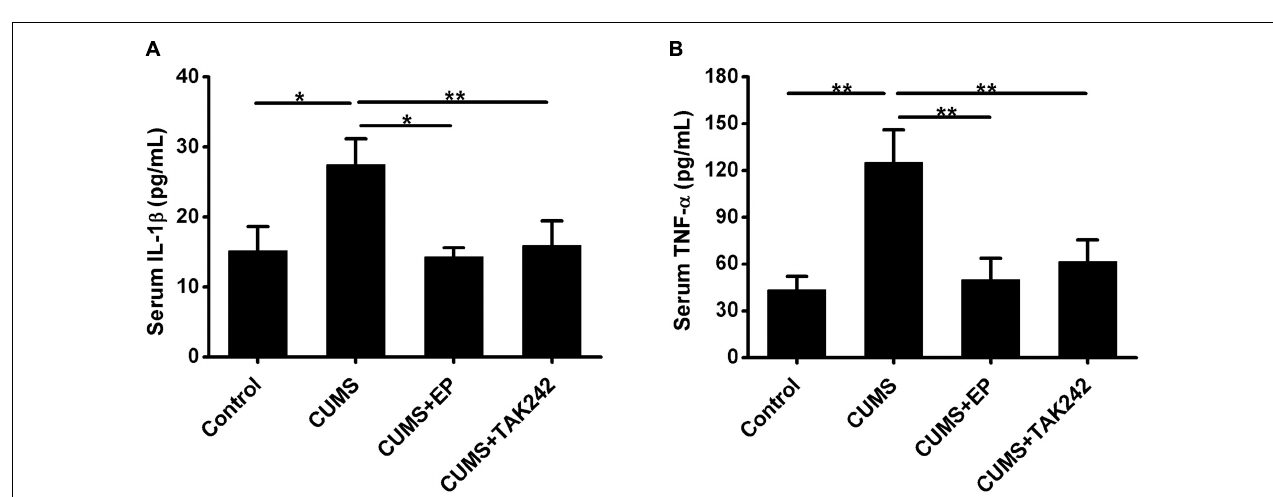
FIGURE 4 | Effect of EP and TAK-242 treatment on CD68 protein expressions in aortic sinus of CUMS ApoE − / − mice. Over a 16-week period treatment, entire aorta from the aortic root to the iliac bifurcation was harvested, and then frozen-sections of aortic sinus were performed for immunofluorescent staining of CD68. (A) Representative images of CD68 expression in aortic sinus. (B) Quantification of CD68 positive areas in aortic sinus lesions revealed that inhibition of HMGB1 and TLR4 caused in a significant decrease in infiltrating macrophages induced by CUMS. CD68-positive cells seem in red, and nuclei in blue. Data were expressed as mean ± SEM ( n = 5). Statistical analysis was performed by Student’s t -test or one-way analysis of variance. ∗∗ P < 0.01, ∗∗∗ P < 0.01.